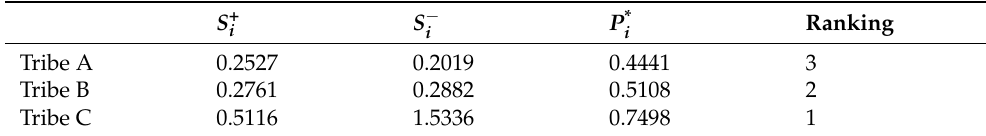
Table 5. Final ranking of tribes.